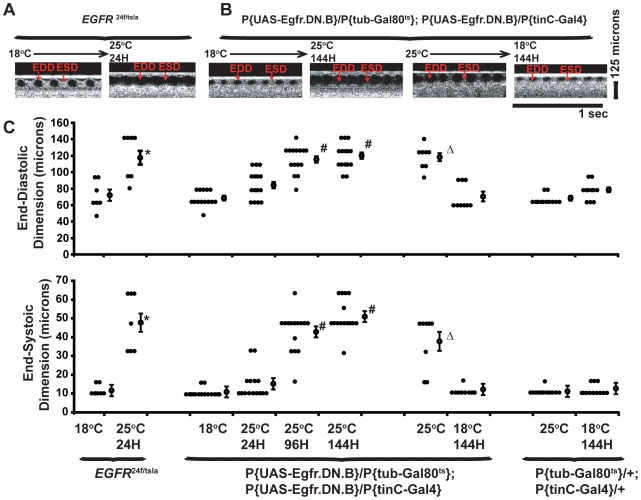
Cardiac expression of dominant negative EGFR (EGFR.DN) causes a progressive post-developmental enlarged heart and impaired systolic function in adult Drosophila.(A) Representative m-mode OCT images for EGFRf24
/tsla at 18°C (baseline) and 24 hours after temperature shift to 25°C. Horizontal bar represents one second, 125 micron standard is shown. (B) Representative m-mode OCT images for p{UAS-EGFR.DN}/p{tub-Gal80ts}; p{UAS-EGFR.DN}/p{tinC-Gal4}, at 18°C (baseline) and 144 hours after temperature shift to 25°C or 25°C (baseline) and 144 hours after temperature shift to 18°C. OCT m-modes are from the same fly obtained at the indicated temperature and time intervals. Horizontal bar represents one second, 125 micron standard is shown. (C) Summary OCT data for end-diastolic dimension (EDD) (top) and end-systolic dimension (ESD) (bottom) for EGFRf24
/tsla maintained at 18°C and after 24 hours at 25°C and p{UAS-EGFR.DN}/p{tubulin-Gal80ts}; p{UAS-EGFR.DN}/p{tinC-Gal4} maintained at 18°C followed by 24 hour, 96 hours, and 144 hours at 25°C. The summary also shows data for the reversal of the cardiac phenotype for p{UAS-EGFR.DN}/p{tubulin-Gal80ts}; p{UAS-EGFR.DN}/p{tinC-Gal4} maintained at 25°C then shifted to 18°C for 144 hours. Data for EGFRf24/tsla (n = 7) and p{UAS-EGFR.DN}/p{tubulin-Gal80ts}; p{UAS-EGFR.DN}/p{tinC-Gal4} (n = 15) experiments was obtained by serial OCT measurements in individual flies. The cardiac chamber sizes in p{tubulin-Gal80ts}/+; p{tinC-Gal4}/+ that did not harbor a UAS-EGFR.DN transgene were used as controls and examined at 18°C and 25°C. *p<0.05 for EGFRf24
/tsla at 25°C versus 18°C baseline. #p<0.05 for p{UAS-EGFR.DN}/p{tubulin-Gal80ts}; p{UAS-EGFR.DN}/p{tinC-Gal4} at 25°C for 96 or 144 hours versus 18°C baseline; Δp<0.05 for p{UAS-EGFR.DN}/p{tubulin-Gal80ts}; p{UAS-EGFR.DN}/p{tinC-Gal4} at 18°C for 144 hours versus 25°C baseline. Closed circles represent individual measurements for each group, open circles represent the mean ± SEM for each group.